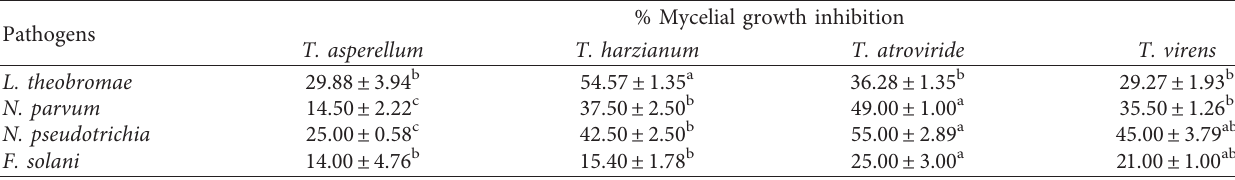
Table 2: Antagonistic activity of Trichoderma spp. against SER fungal pathogens in vitro .